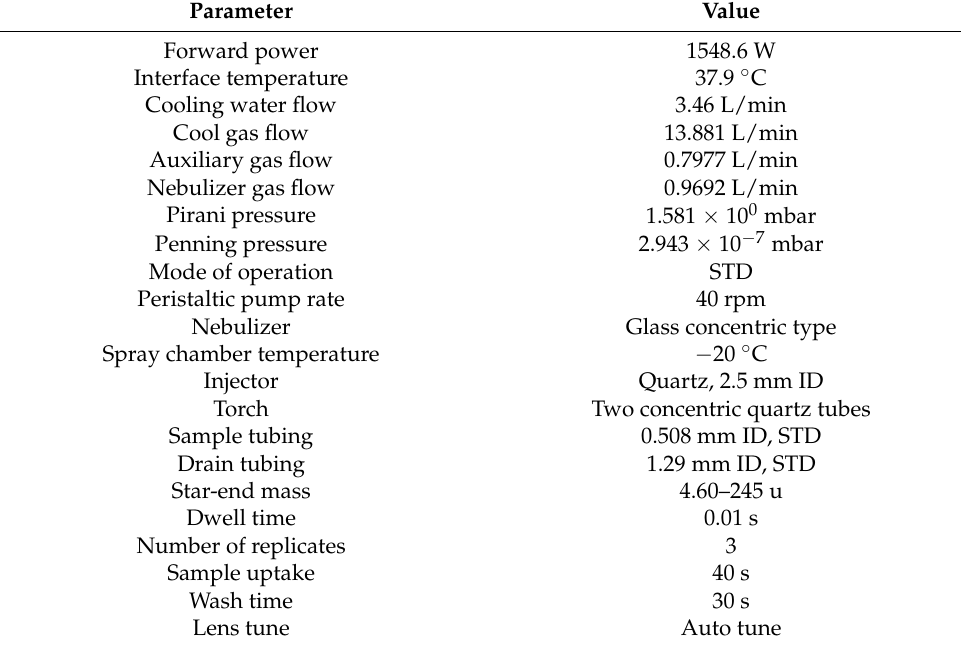
Table 2. iCAP Q ICP-MS operating